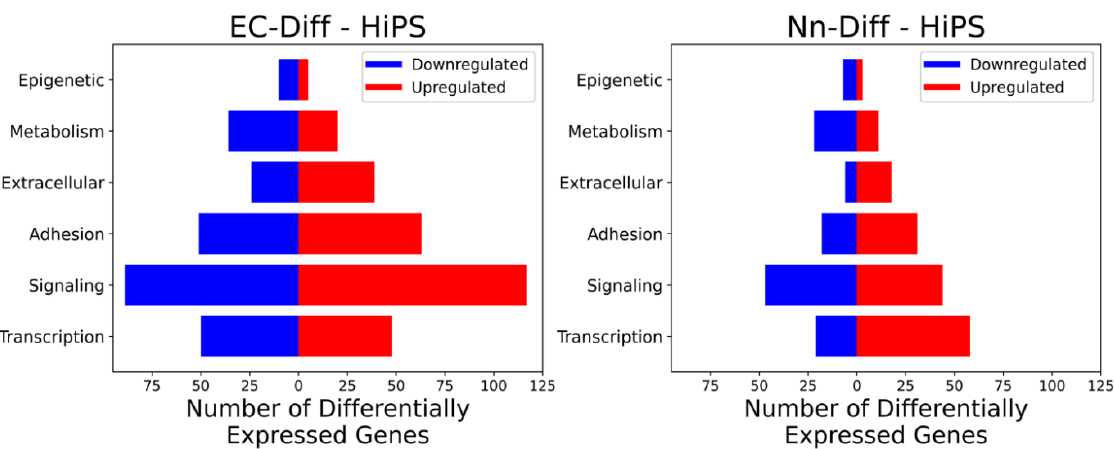
Figure 2. Subplots of differentially expressed genes based on their ontology . The subplots show genes that were differentially expressed in endothelial (Ec-Diff-HiPS) or neural (Nn-Diff-HiPS) lineages compared to HiPS, both upregulated (red) and downregulated (blue). In both subplots, the genes are stratified into the six functional ontologies, indicated on the y -axis. The x -axis shows the number of genes that were up- or downregulated in each lineage.